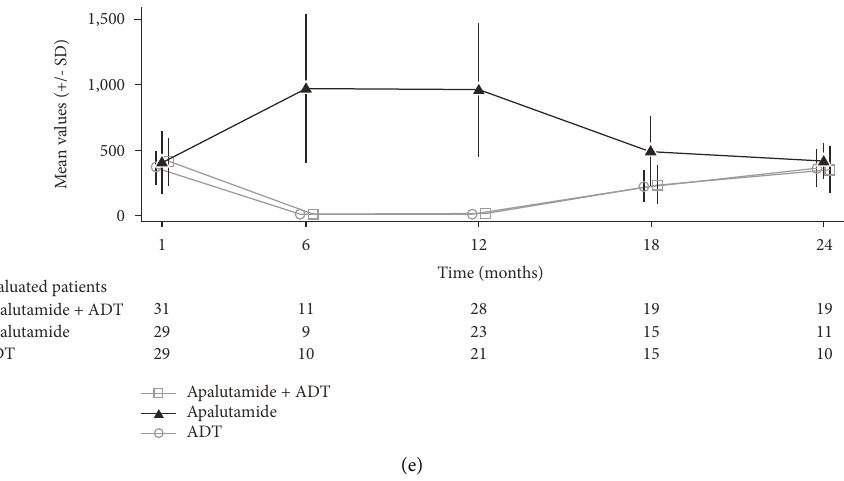
Figure 2: (a) Difference between LS mean change from baseline in FACT-P total scores in apalutamide plus ADTand ADTmonotherapy groups. LS mean difference < 0 favors ADT. (b) Difference between LS mean change from baseline in FACT-P total scores between apalutamide monotherapy and ADT monotherapy groups. LS mean difference < 0 favors ADT. (c) Median time to PSA progression. (d) Median time to serum testosterone ( T ) recovery ( T > 150ng/dL). (e) Mean T levels over